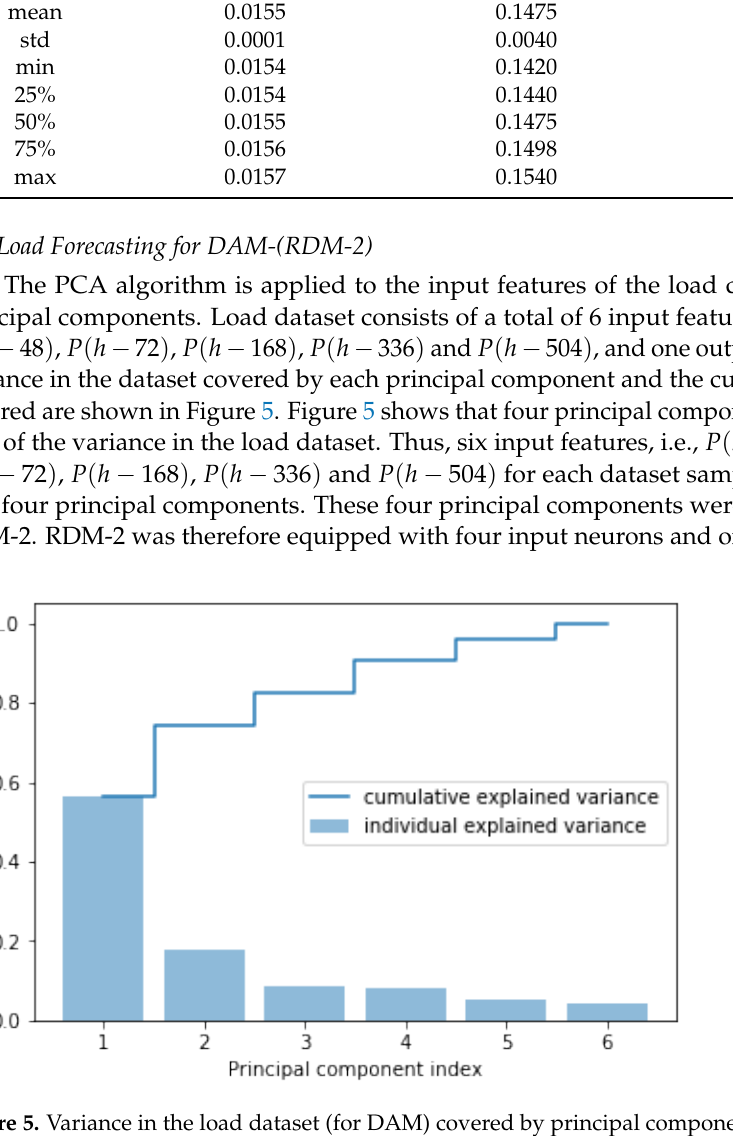
Figure 5. Variance in the load dataset (for DAM) covered by principal